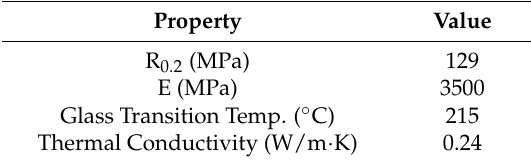
Table 1. Summarized polyetherimide (PEI) properties [17].